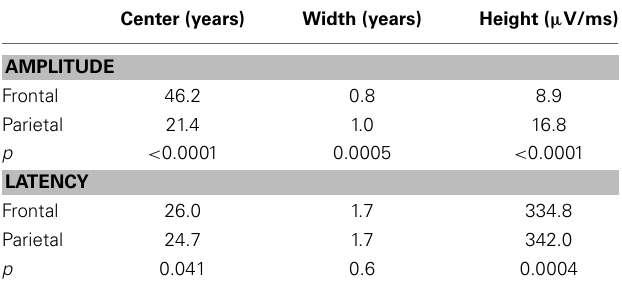
Table 2 | Frontal vs. parietal model